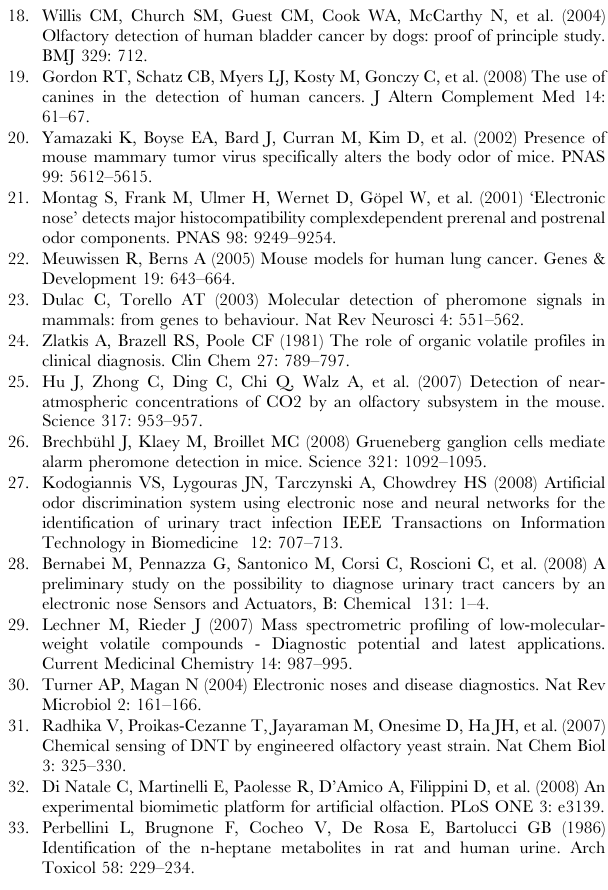
Figure S5 Generalization performance in ROC space of paired peaks. Each box (A–K) provides an overall visual representation of ROC obtained from generalization to the LKR test group by the LKR training group. Red dots indicate mean sensitivity (vertical axis) and mean specify (horizontal axis, 1-specificity) for each classifier. The number of paired peaks are: A, 1; B, 2; C, 3; D, 4; E, 5; F, 6; G, 7; H, 8; I, 9; J, 10; K, 11. Each box (L–V) provides an overall visual representation of ROC obtained from generalization to the LLC test group by the LLC training group. Red dots indicate mean sensitivity (vertical axis) and mean specify (horizontal axis, 1-specificity) for each classifier. The number of paired peaks are: L, 1; M, 2; N, 3; O, 4; P, 5; Q, 6; R, 7; S, 8; T, 9; U, 10; V, 11. Found at: doi:10.1371/journal.pone.0008819.s005 (0.67 MB PDF) Figure S6 Generalization performance in ROC space of paired peaks. Each box (A–K) provides an overall visual representation of ROC obtained from generalization to the LLC test group by the LKR training group. Red dots indicate mean sensitivity (vertical axis) and mean specify (horizontal axis, 1-specificity) for each classifier. The number of paired peaks are: A, 1; B, 2; C, 3; D, 4; E, 5; F, 6; G, 7; H, 8; I, 9; J, 10; K, 11. Each box (L–V) provides an overall visual representation of ROC obtained from generalization to the LKR test group by the LLC training group. Red dots indicate mean sensitivity (vertical axis) and mean specify (horizontal axis, 1-specificity) for each classifier. The number of paired peaks are: L, 1; M, 2; N, 3; O, 4; P, 5; Q, 6; R, 7; S, 8; T, 9; U, 10; V, 11. Found at: doi:10.1371/journal.pone.0008819.s006 (0.70 MB PDF)